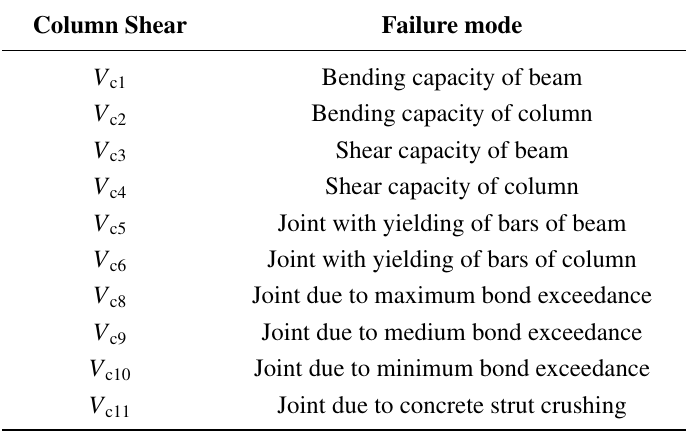
, for each considered failure mode. c